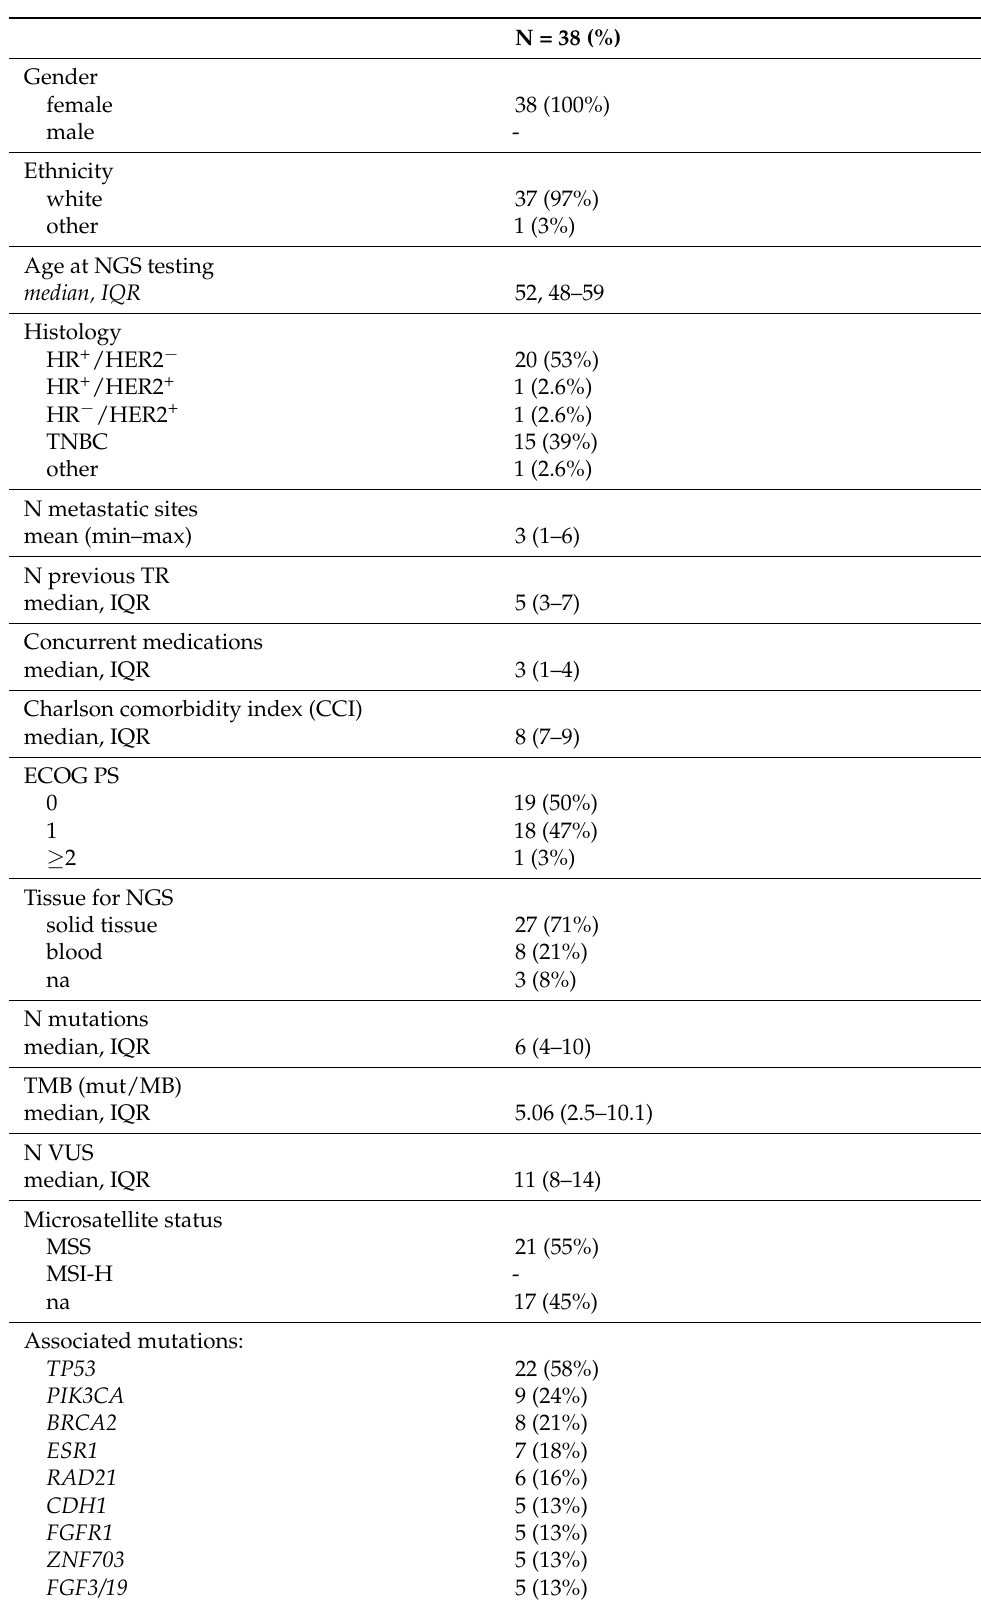
Table 1. Clinical and molecular characteristics of BC